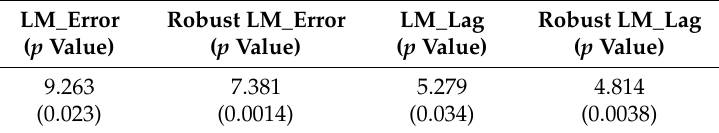
Table 6. Spatial correlation tests for the absolute β -convergence model.